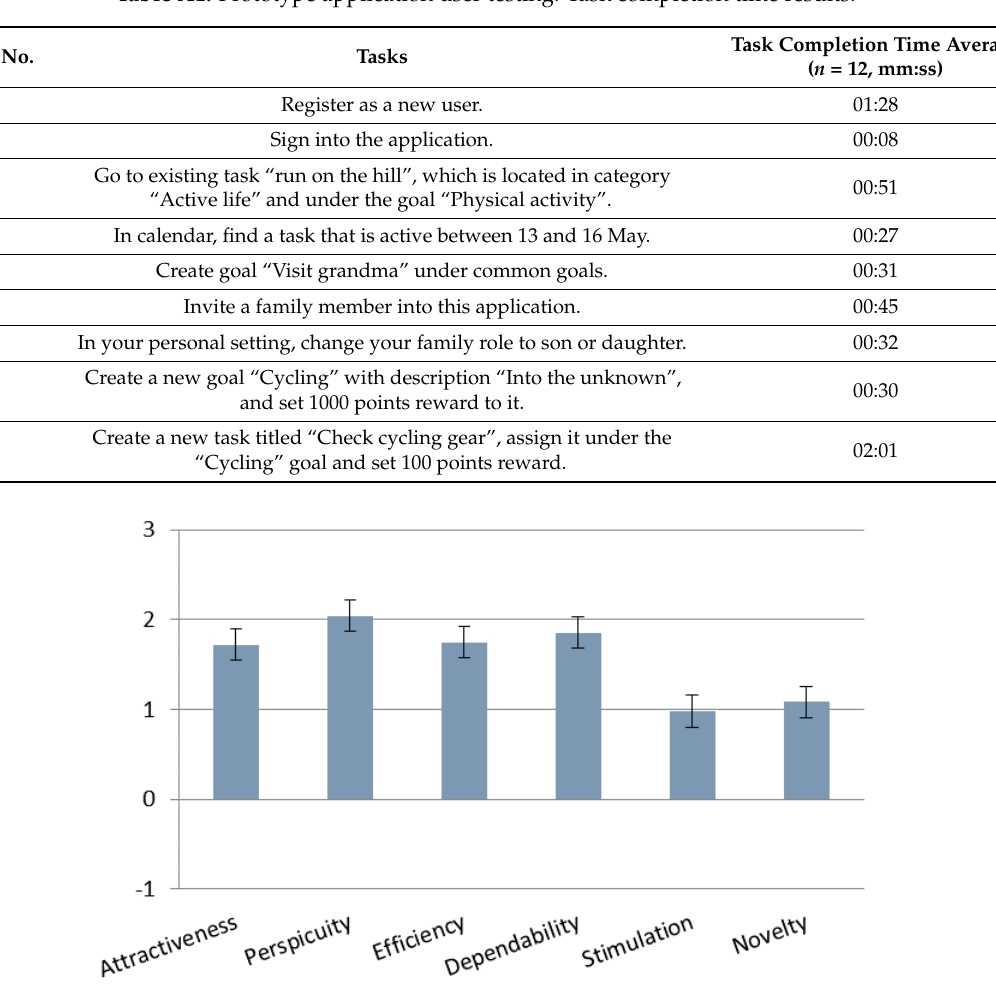
Figure A2. Preliminary prototype application user testing: User Experience Questionnaire results.